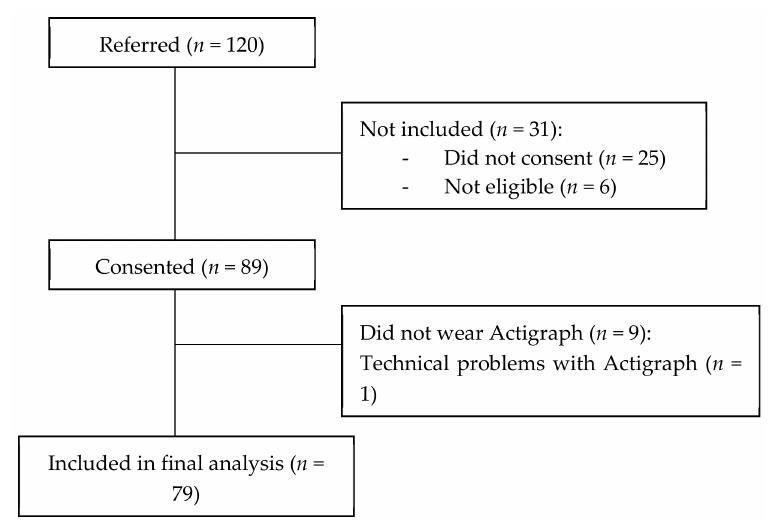
Figure 1. Flow of participants throughout this